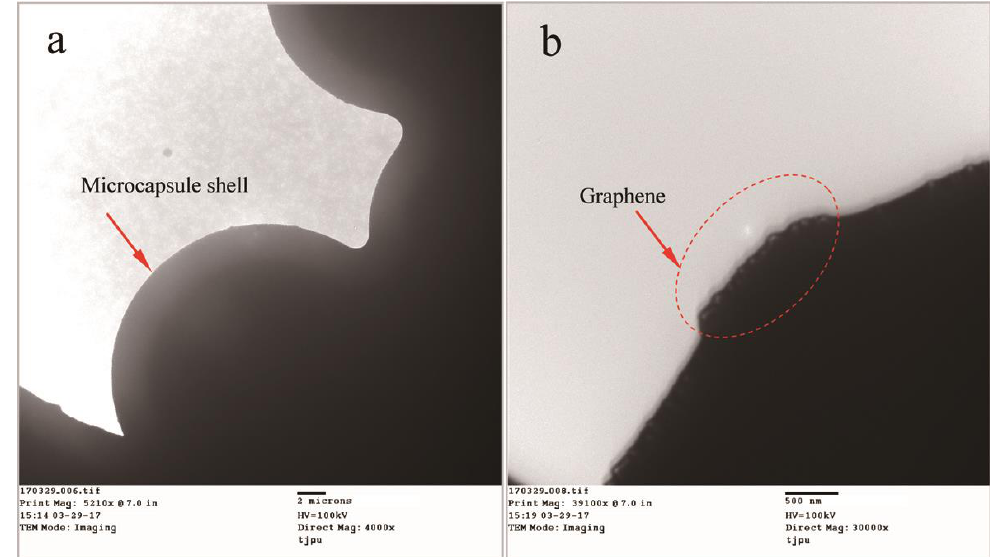
Figure 8. TEM morphologies of microcapsules (MG-2) with graphene/organic structure shells, ( a ) the microcapsules on a copper screen, and ( b ) graphene sheets with a size of 100 nm extended out of a microcapsule shell surface.